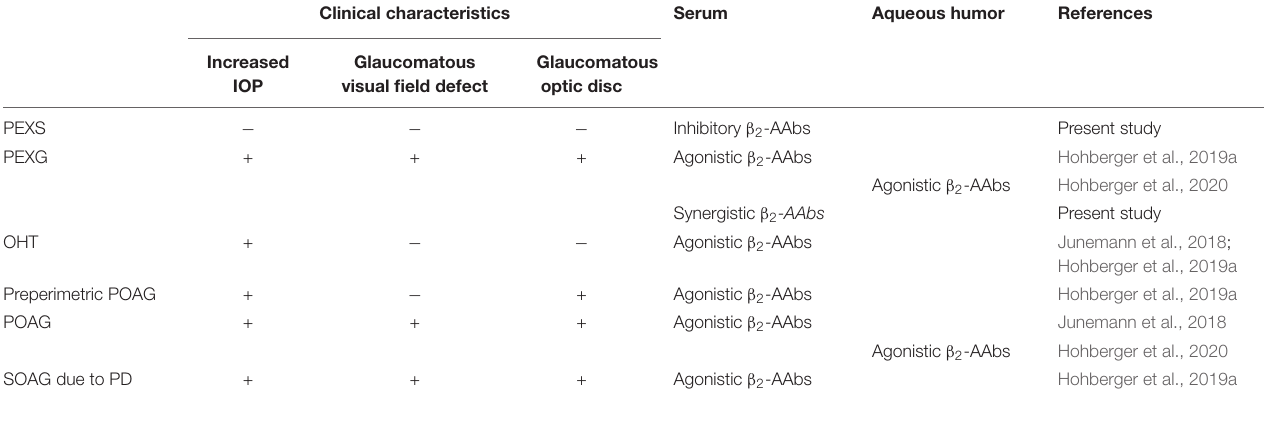
TABLE 2 | Autoantibodies targeting the adrenergic β 2 -AR in glaucoma suspects and patients with glaucoma: pseudoexfoliation syndrome (PEXS), pseudoexfoliation glaucoma (PEXG), ocular hypertension (OHT), primary open-angle glaucoma (POAG), secondary open-angle glaucoma (SOAG), and pigment dispersion (PD). Clinical